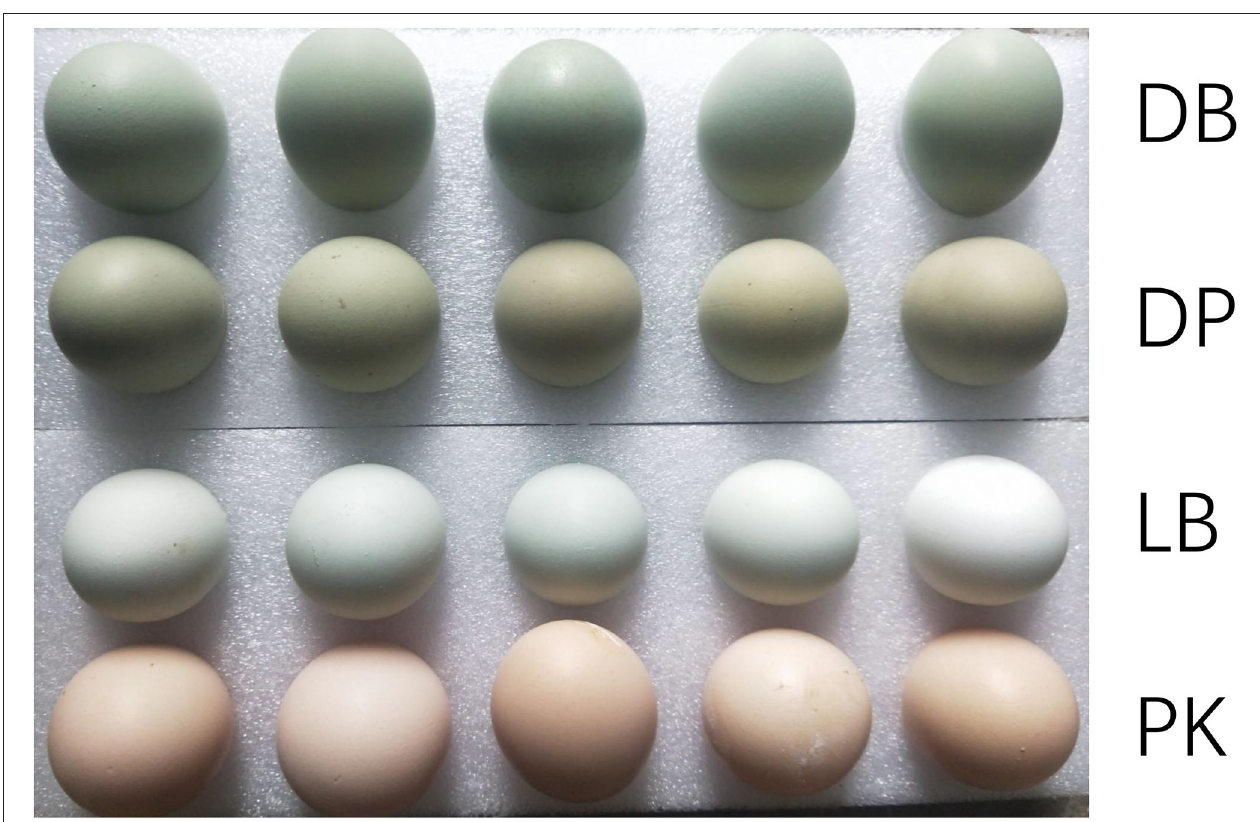
FIGURE 1 | The description of four different eggshell colors of Changshun blue-eggshell chicken. DB, DP, LB, and PK mean chickens producing dark blue, dark brown and greenish, light blue, and pink eggshell eggs,